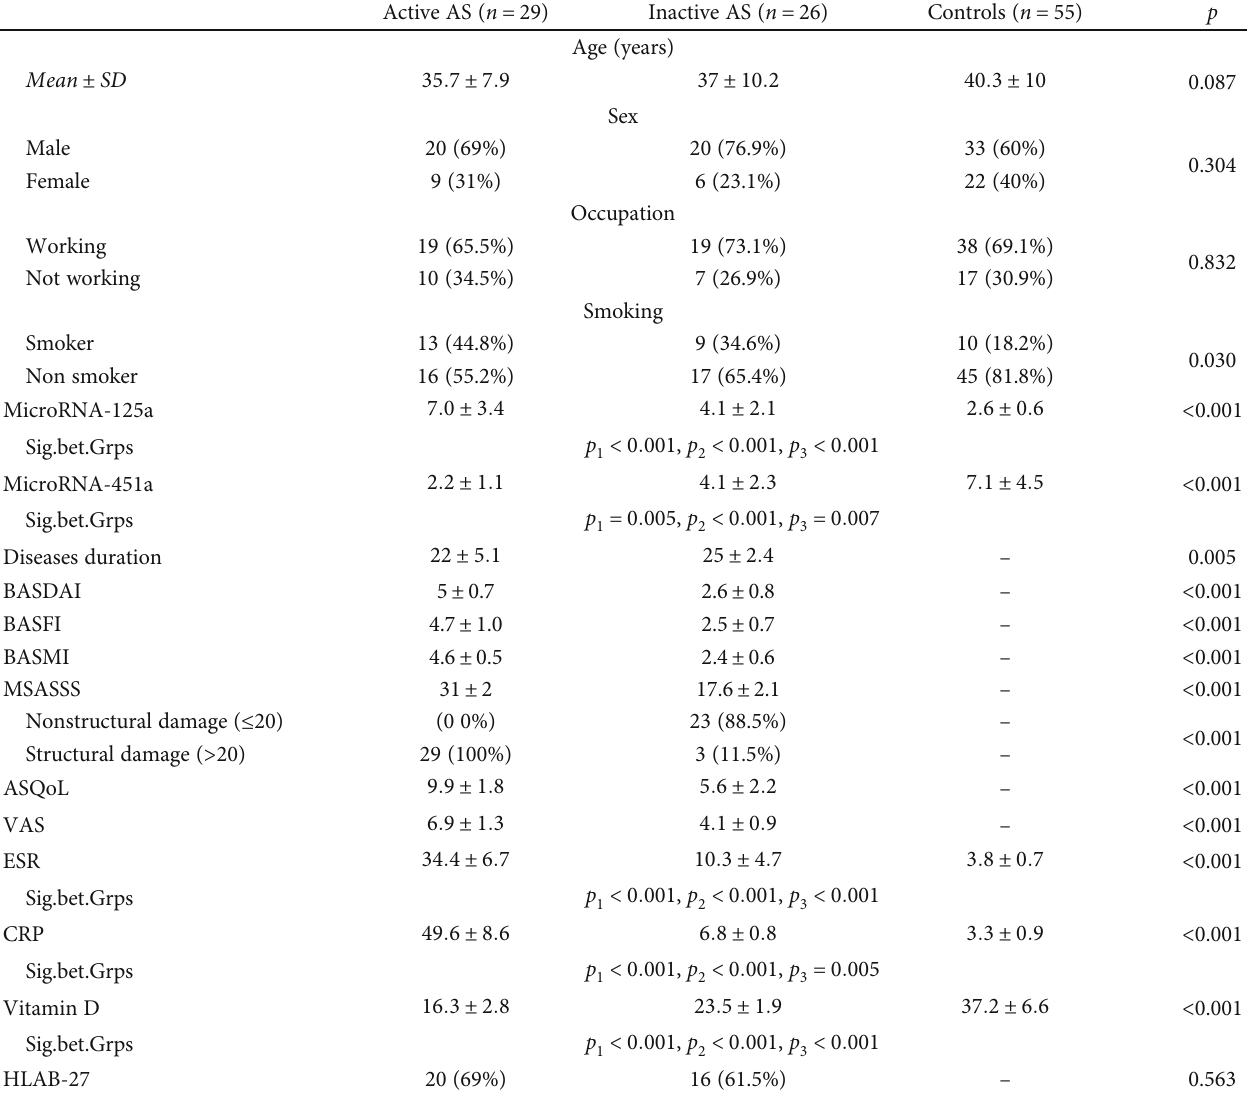
Table 1: Comparison between the three studied groups according to di ff erent